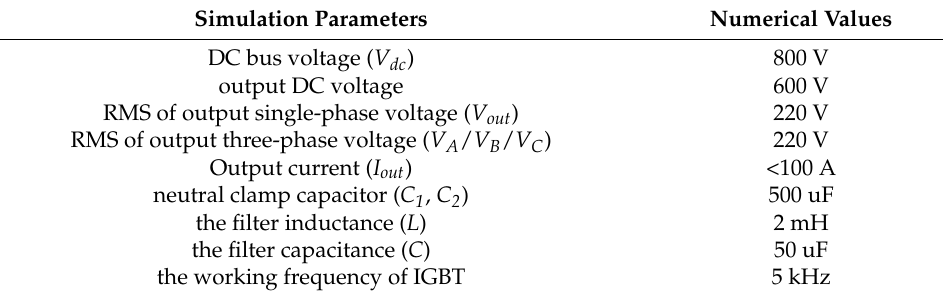
Table 1. Simulation parameters of the MCMs converter.